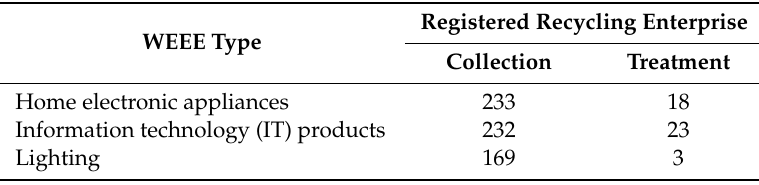
Table 4. Registered E-waste collection and treatment facilities in Taiwan a .